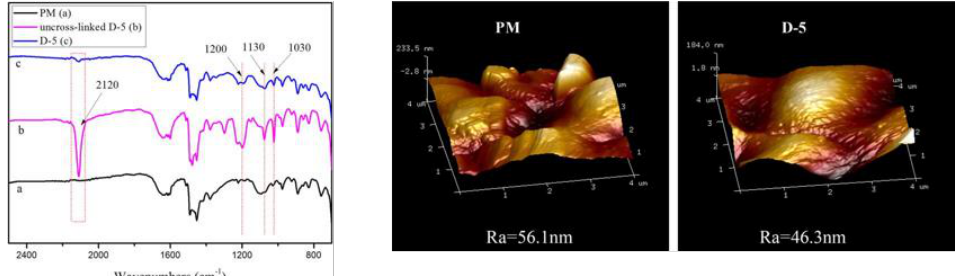
Figure 7. FTIR spectra ( left ) and AFM images ( right ) of a commercial AEM (PM), before and after modification. Reproduced with permission from [70].